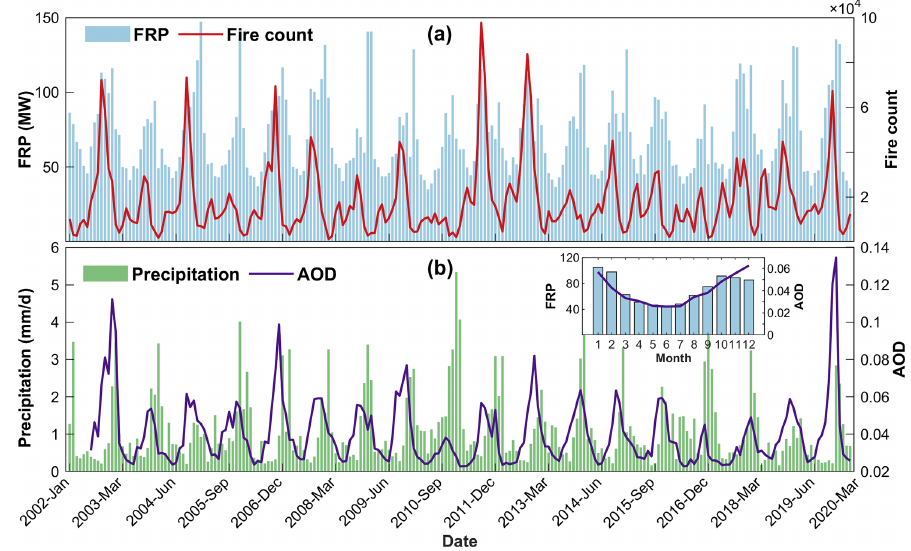
Figure 2. Time series of monthly averaged fire radiative power (FRP), fire count from MCD14ML (a) , and total precipitation from ERA-5 and Aqua MODIS DB AOD (b) in